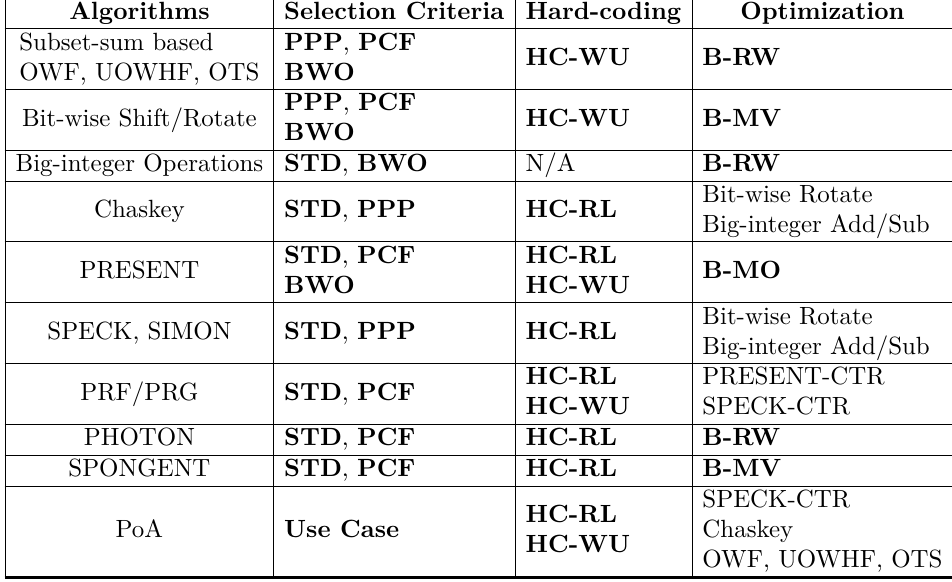
Table 3: Overview of algorithms in PLCrypto , and their corresponding selection criteria and optimization